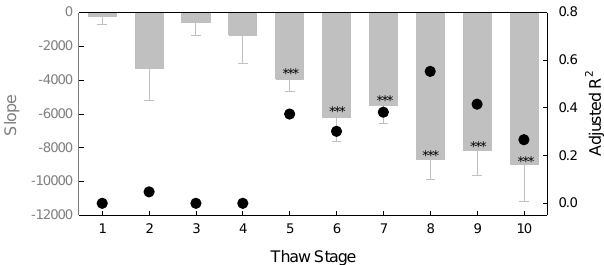
Figure 5. Slope and adjusted R 2 from the Arrhenius plots (Fig. 4a) of each thaw stage. The left y axis is the estimate and standard error of the slope of the fit (represented by the gray bars ± standard error) and the right y axis shows the R 2 of each fit (represented by the black dots). The significant regressions ( p < 0.0001) are denoted by asterisk. Variance of CH 4 fluxes explained by soil temperature generally increases and becomes more significant ( p values) from less to more thawed stages. Slope of the soil temperature to CH 4 flux relationship also increases with increased